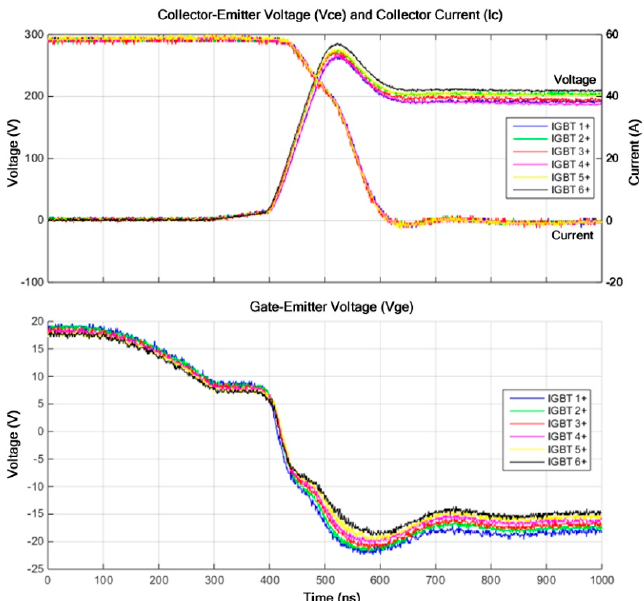
Figure 19. Turn-off switching with 60 A load current. The increase in the natural intrinsic balancing effects with the increase of the collector current, from instant 430 ns is also seen.